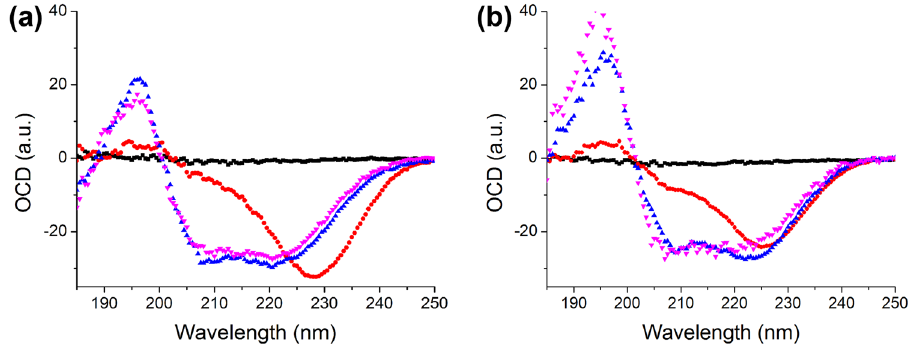
Figure 2. OCD measured at ~100% RH ( a ) DMPC: DMPG = 0.75:0.25; ( b ) DMPC: DMPG = 0.5:0.5. Lipid only (black); P/L = 1/100 (purple); P/L = 1/30 (blue); P/L = 1/10